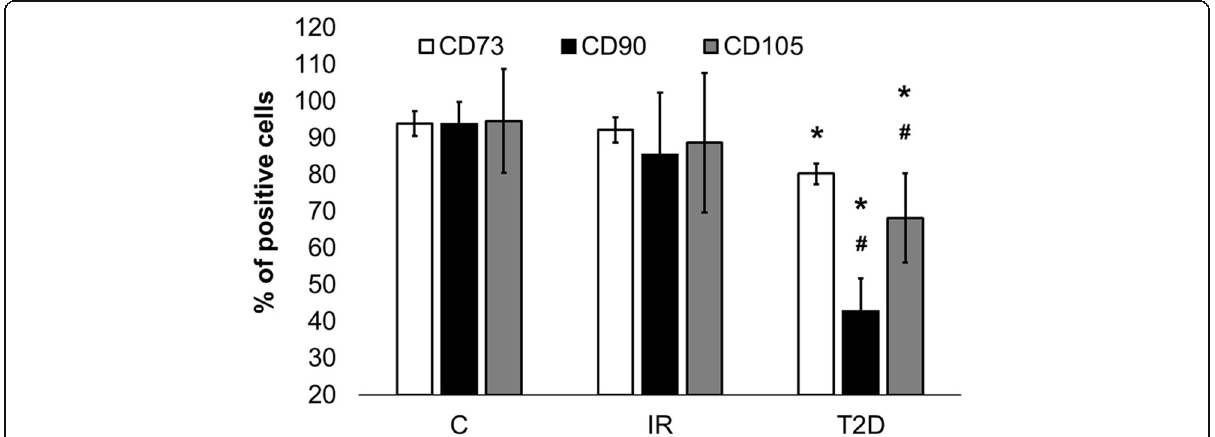
Fig. 3 The percentage of positive cells for CD73, CD90 and CD105 markers in cells from patients with insulin-resistance (IR), type 2 diabetes (T2D) compared to control cells (C). The bars represent the means ± standard deviation (SD); ANOVA with the Tukey post hoc test * p < 0.05 vs. C, # p < 0.05 vs. IR